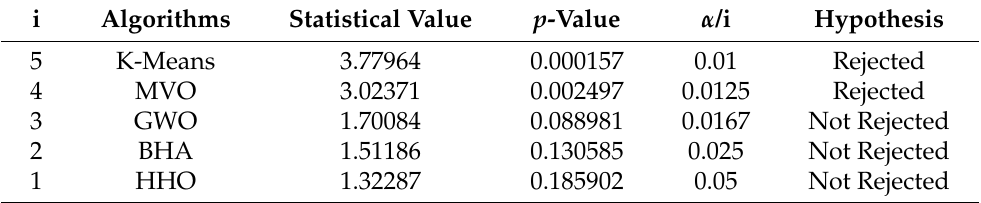
Table 9. Holm’s test statistical results based on mean of objective values for UCI datasets.